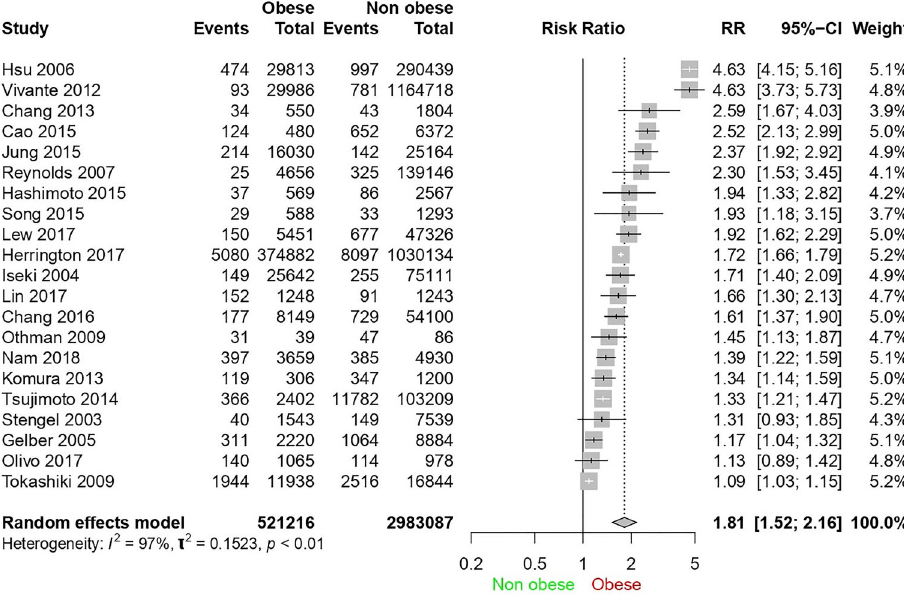
Figure 2. Forest plot of chronic kidney disease cases in obese and non-obese